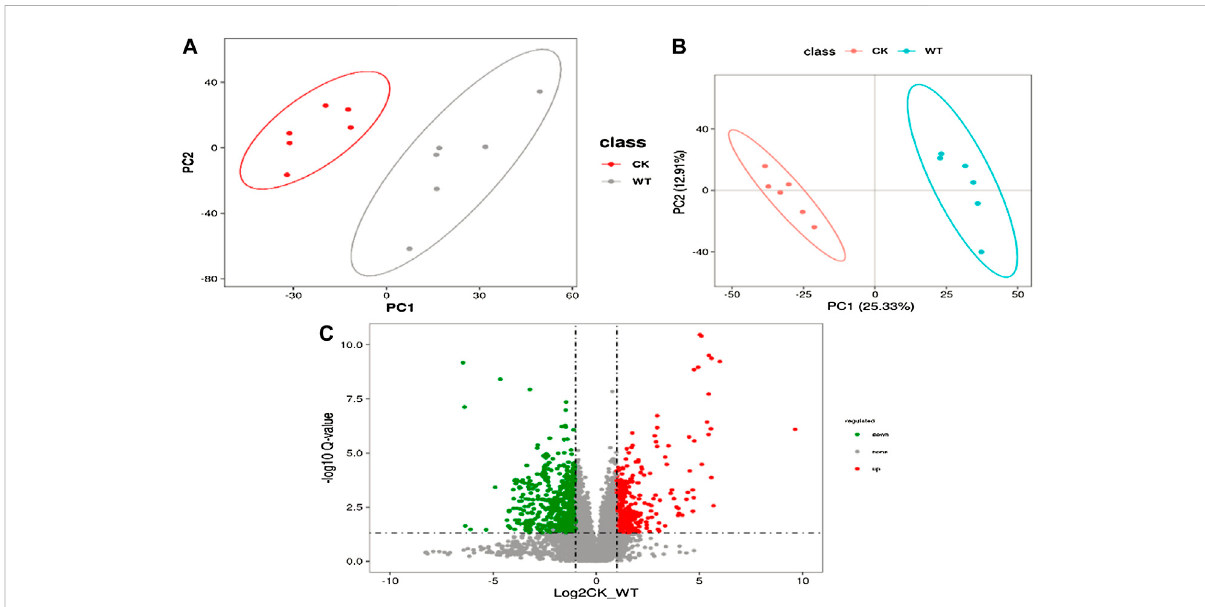
FIGURE 1 PCA (A) and PLS-DA (B) score plots of all detected metabolites in the AR-Cd treatment group. (C) Vocalno plot of differentially accumulated metabolitesinCKvs.WTleaves.ReddotsaremetabolitesaccumulatedmoreinAR-Cdtreatment,andgreendotsaremetabolitesaccumulatedmore in control